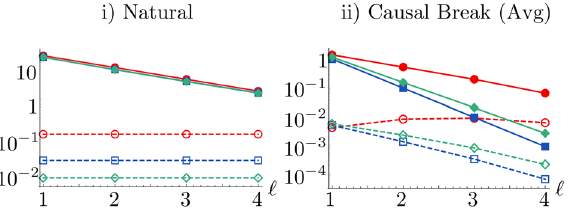
Fig. 3 Case study. We plot jh C i ϒ (cid:2) h C i Λ J j (hollow, dashed) and M FMH FMH the proxy memory strength based on the relative entropy between the Choi states of the true and recovered processes (see Supplementary Methods D) (solid) for (i) the identity map and (ii) a causal break. We construct a six-step process tensor in the strongly non-Markovian (red, circles), CP-divisible (blue, squares), and intermediate (green, diamonds) regimes, and consider the memory strength over ℓ applications of said